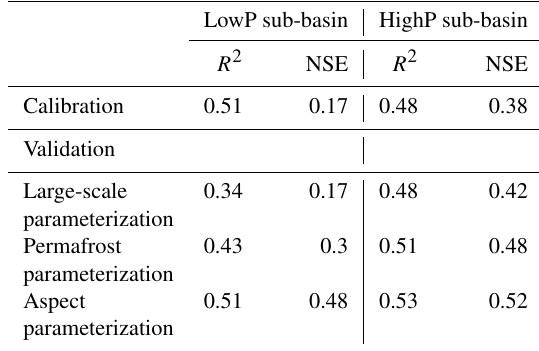
Table 5. Coefficient of determination ( R 2 ) and Nash–Sutcliffe ef- ficiency (NSE) values for the LowP and HighP sub-basins for cali- bration and validation